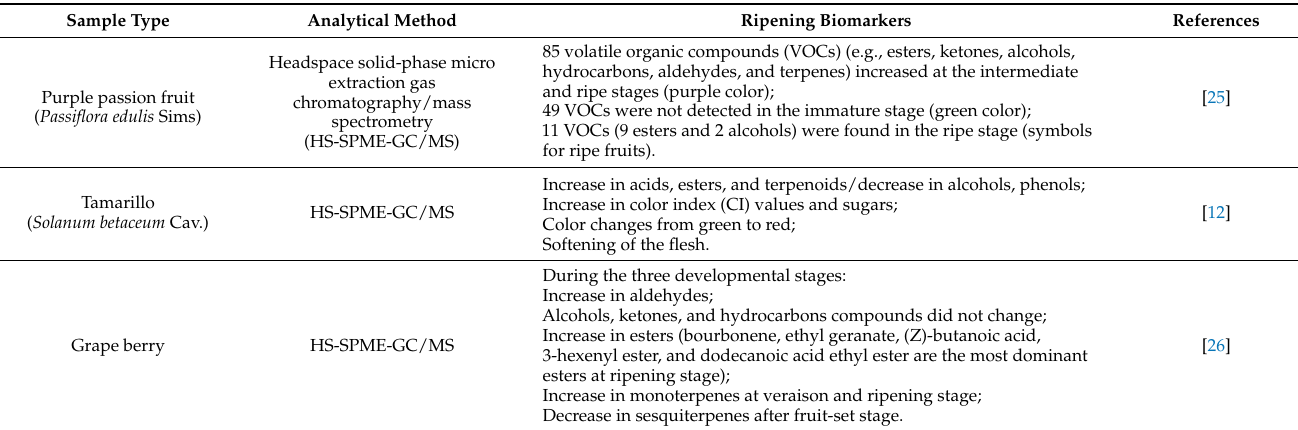
Table 1. Studies focusing on fruit VOCs